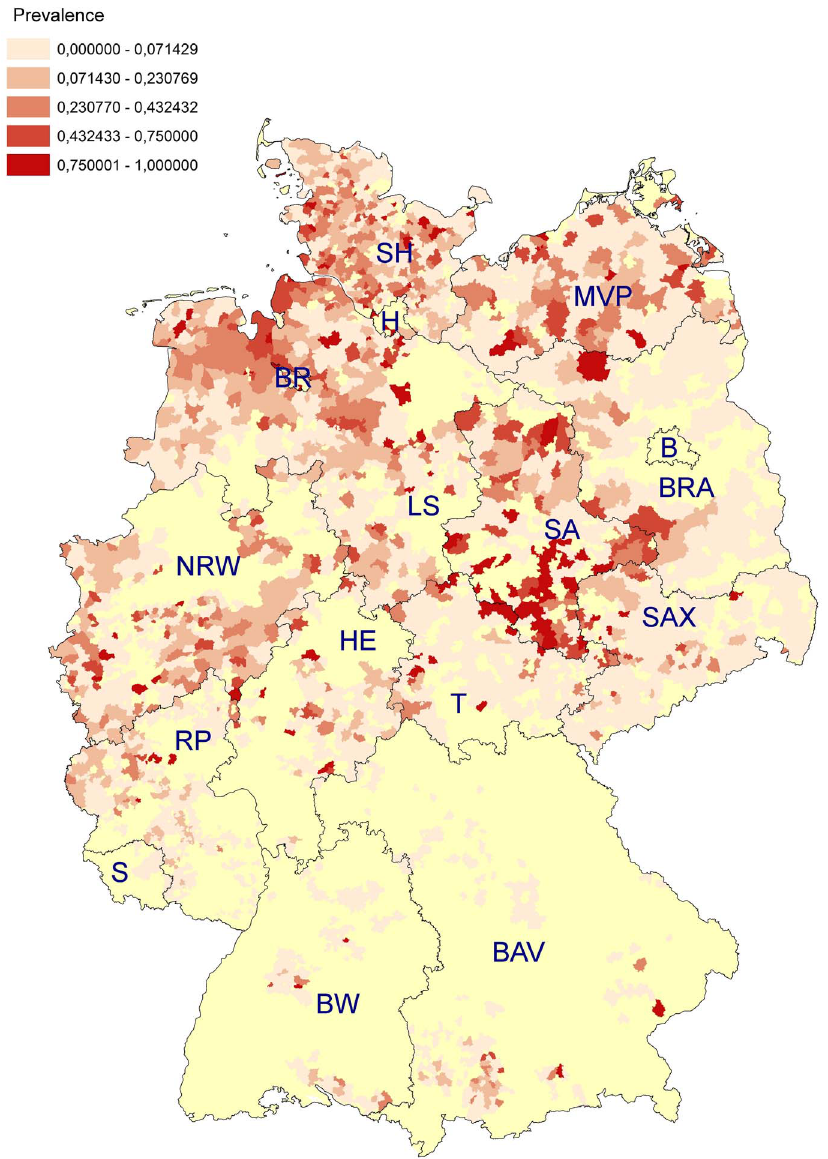
Figure 3. Prevalence for the several postal code districts (No. of positive samples/No. of samples per postal code district). The yellow colour marks postal code districts which were not sampled. Federal states are abbreviated as follows: B=Berlin, BAV=Bavaria, BR=Bremen; BRA=Brandenburg, BW=Baden-Wu¨rttemberg, H=Hamburg, HE=Hesse, LS=Lower Saxony, MWP=Mecklenburg-Western Pomerania, NRW=North Rhine-Westphalia, RP=Rhineland-Palatinate, S=Saarland, SA=Saxony-Anhalt, SAX=Saxony, SH=Schleswig-Holstein, T=Thuringia. association between the results of the BTM samples and temperature during all four quarters (Tm1q – Tm4q) together, combined with the respective altitudes. In this analysis Tm1q and Tm3q revealed a positive association, whereas Tm2q and Tm4q showed a negative association. Statistically significant associations were found for the variables Tm1q and Tm2q. Concerning precipitation, a positive association was found by individual analysis for three out of four quarters, P1q, P3q and P4q whereas a negative association became evident for P2q. All precipitation quarters were significantly associated when individually analysed, whereas in the combined analysis of all quarters, only the first quarter failed to show a statistically significant association. In this analysis only P3q resulted in a positive association.